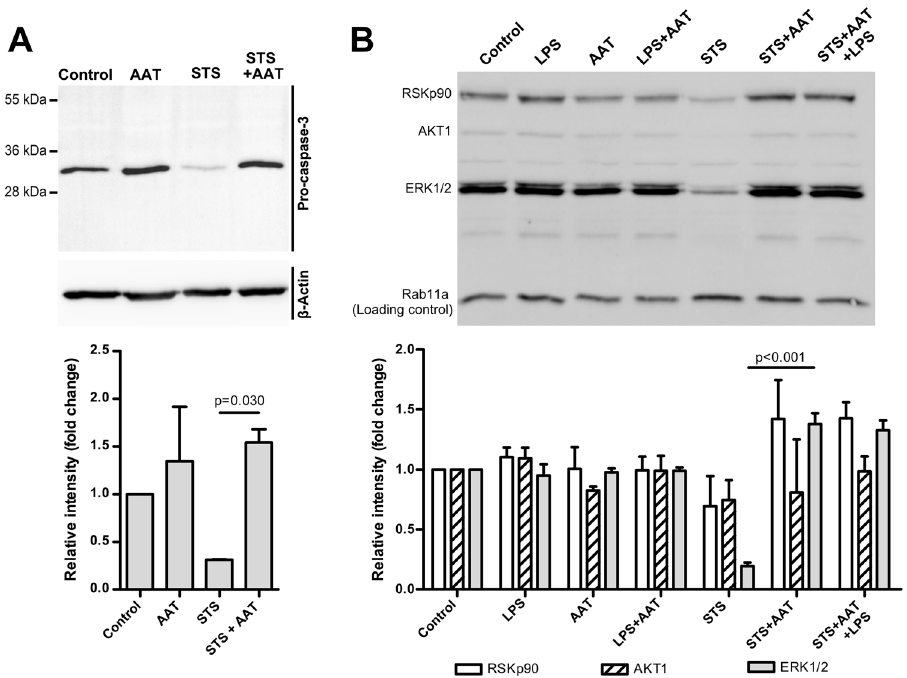
Figure 6. Exogenously added AAT prevents STS-induced pro-caspase-3 cleavage and suppression of Akt and MAPK pathways. ( A ) H1975 cells were cultured for 18 h in the medium alone (controls), and in the medium containing 50 nM STS alone or in combination with 1.5 mg/ml AAT. Cell lysates were applied to Western blot analysis. β -actin was used as a loading control. Fold changes were calculated for each band using the ratio relative to β -actin, as a loading control, and then normalized by the experimental control. Bars represent mean (SD) of three independent experiments. ( B ) H1975 cells were incubated for 15 min in medium alone (controls) and in medium containing 50 nM STS, 10 µ g/ml LPS, or 1.5 mg/ml AAT alone or in combinations. Cell lysates were applied to Western blot and analysed with AKT/MAPK signalling pathway antibody cocktail targeting AKT1 (phospho S473), ERK1/2 (phospho Y204/197), RP-S6 (phospho S235/236) and p90 RSK (phospho S380). Fold changes were calculated for each band using the ratio relative to Rab11a, as a loading control, and then normalized by the experimental control. Bars represent mean (standard error, SEM) from three independent experiments. Representative blots are shown. p < 0.05 was considered as